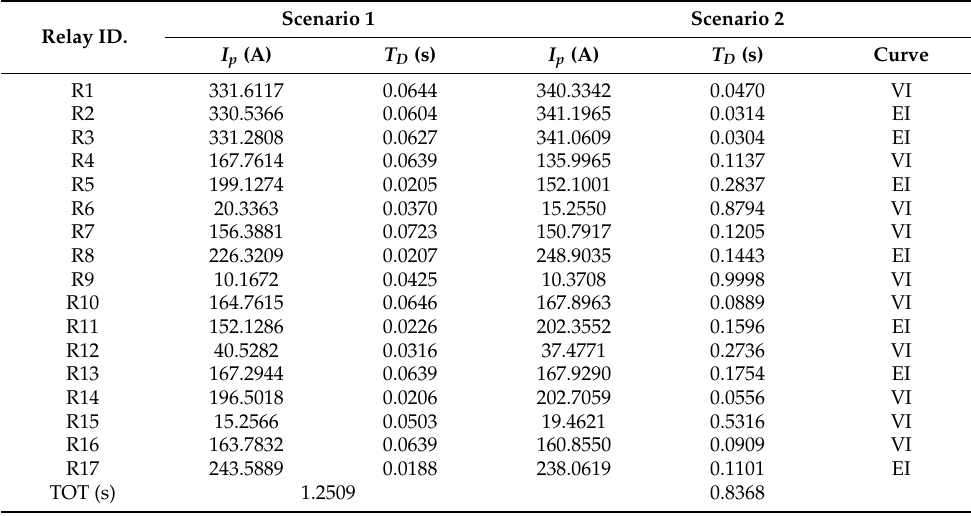
Table 5. OCRs optimum settings of Agiba network using Test Model 1.